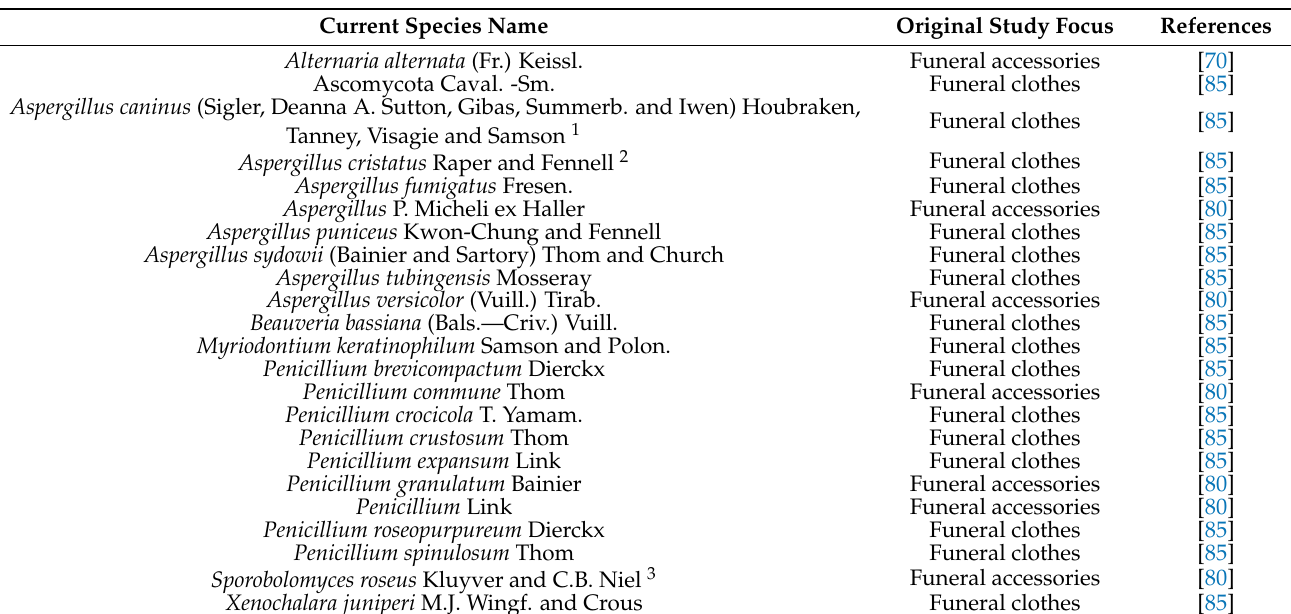
Table 4. Overview of fungal species for which isolates have been identified as displaying fibrinolytic abilities in biodeterio- rative plate